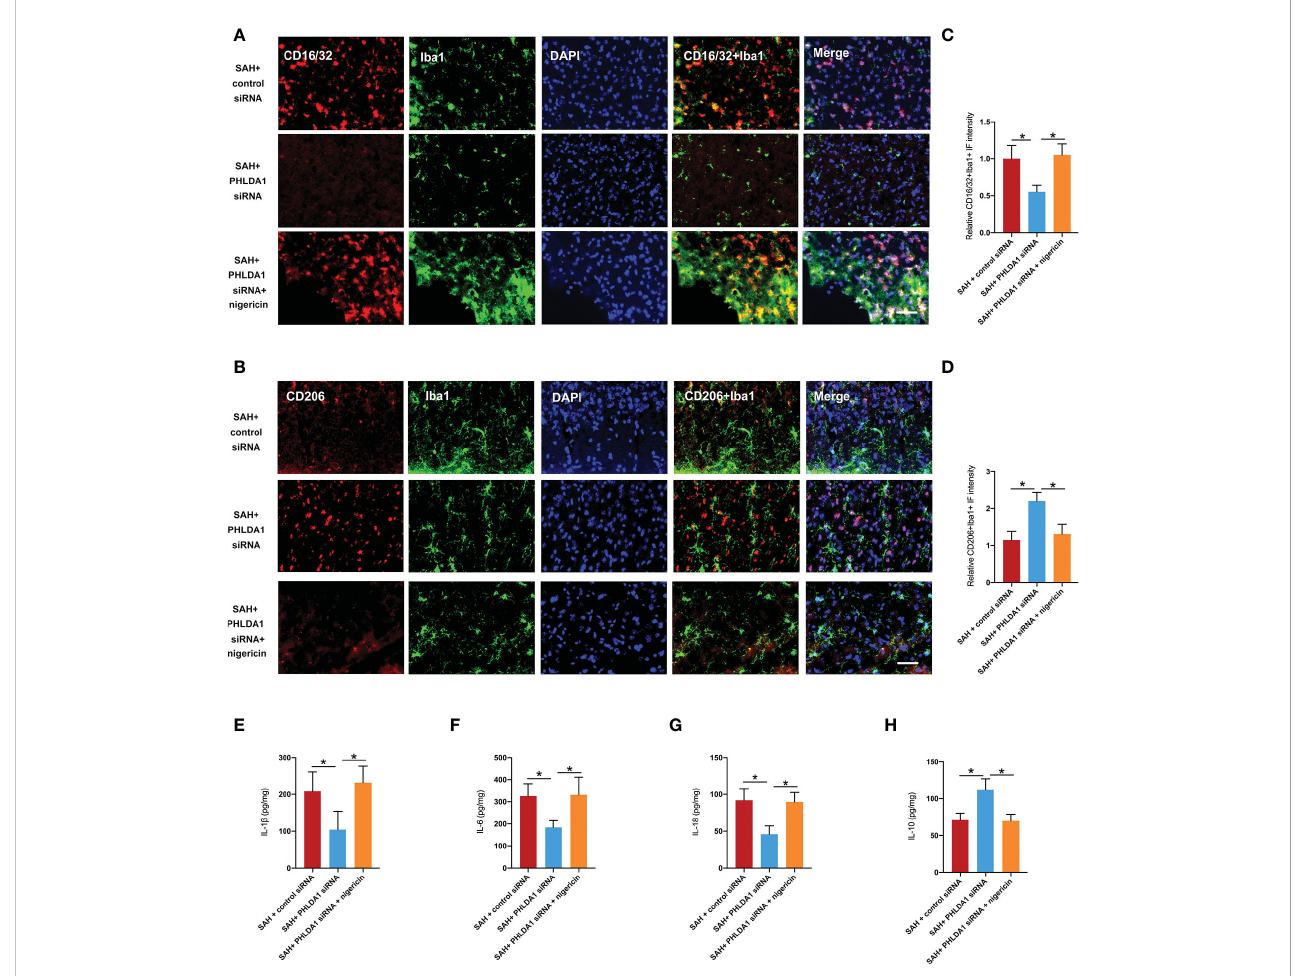
FIGURE 7 Nigericin administration abated the effects of PHLDA1 de fi ciency on microglia M1/M2 polarization and in fl ammatory insults. Representative immuno fl uorescence images of CD16/32 (A) and CD206 (B) co-localized with Iba1 in temporal cortex. Quanti fi cation of Iba1 + /CD16/32 + cells (C) and Iba1 + /CD206 + cells (D) in temporal cortex (n = 6 per group). ELISA analysis of IL-1 b (E) , IL-6 (F) , IL-18 (G) , and IL-10 (H) expressions (n = 6 per group). * P < 0.05. Scale bar=50 m m. Data are expressed as mean ±